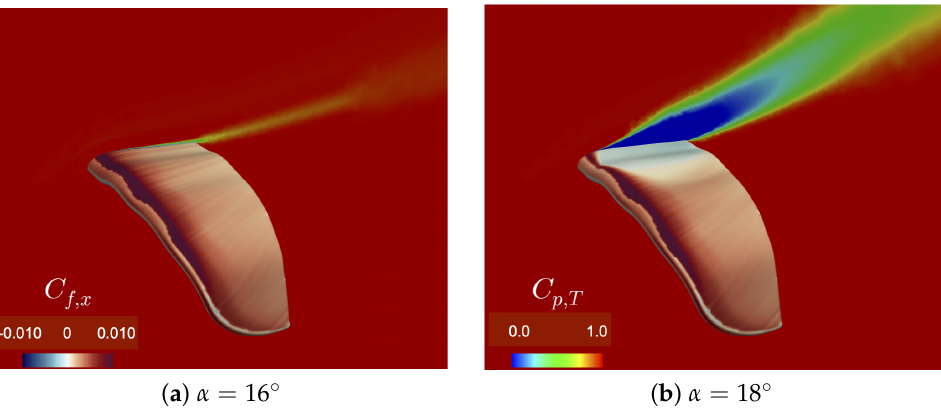
Figure 7. Contour plots of streamwise skin friction coefficient C f , x on the surface and total pressure coefficient C p , T in the symmetry plane ( Z = 0) for Re = 3 × 10 6 and β = 0, taken from [23].